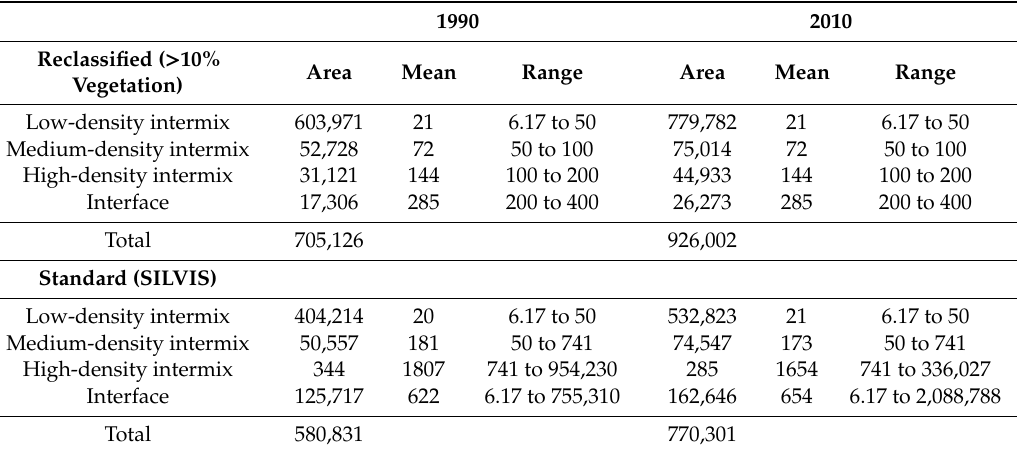
Table 3. Area, and mean and range of housing densities (km 2 ), for di ff erent classes of WUI from reclassified ( > 10% vegetation cover) and standard (SILVIS) WUI definitions (intermix WUI has > 50% vegetation cover and interface WUI has < 50% vegetation and is within 2.4 km of at least 75% wildland vegetation that is at least 5 km 2 in